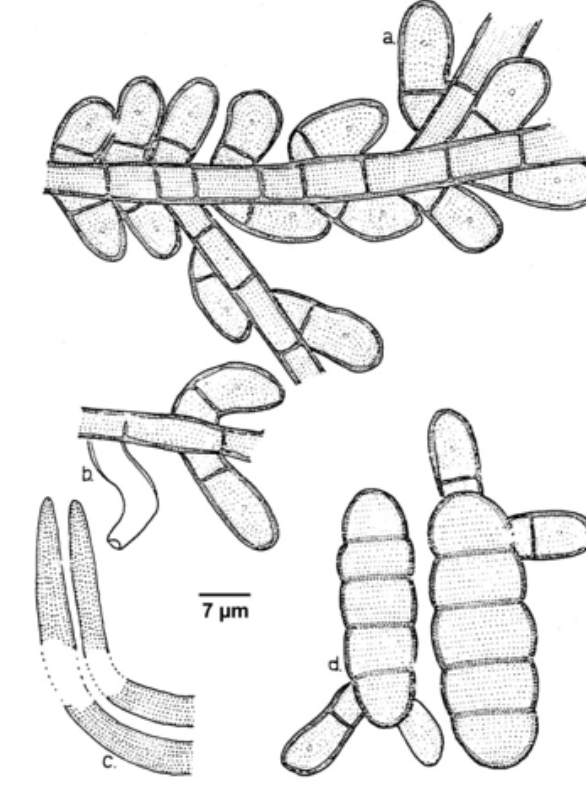
Figure 123. Meliola themedicola a - Appressorium; b - Phialide; c - Apical portion of mycelial setae; d - Ascospores